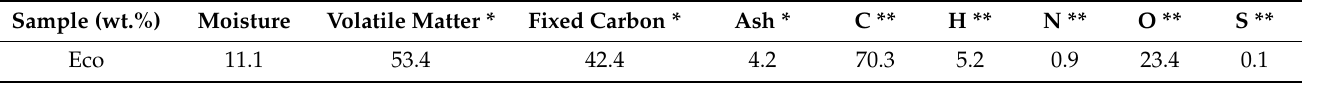
Table 1. Proximate and ultimate analysis of Low rank coal (LRC, Eco coal) (Data from reference [33]). Sample (wt.%) Moisture Volatile Matter * Fixed Carbon * Ash * C ** H ** N ** O ** S ** Eco 11.1 53.4 42.4 4.2